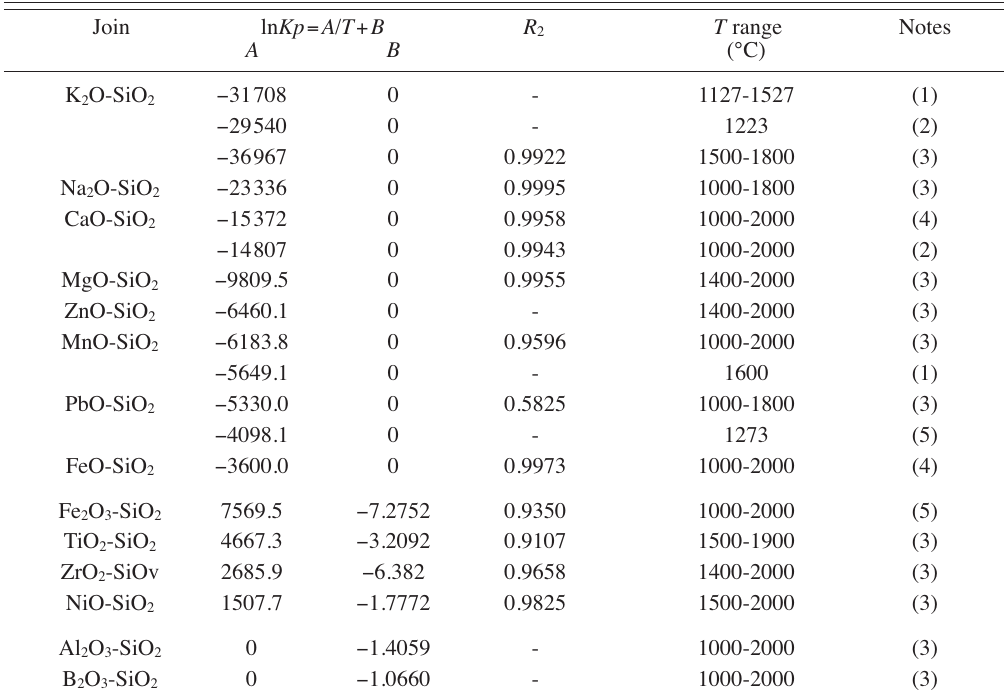
Table V. Chemical interaction of HPM (from Ottonello and Moretti, 2004).